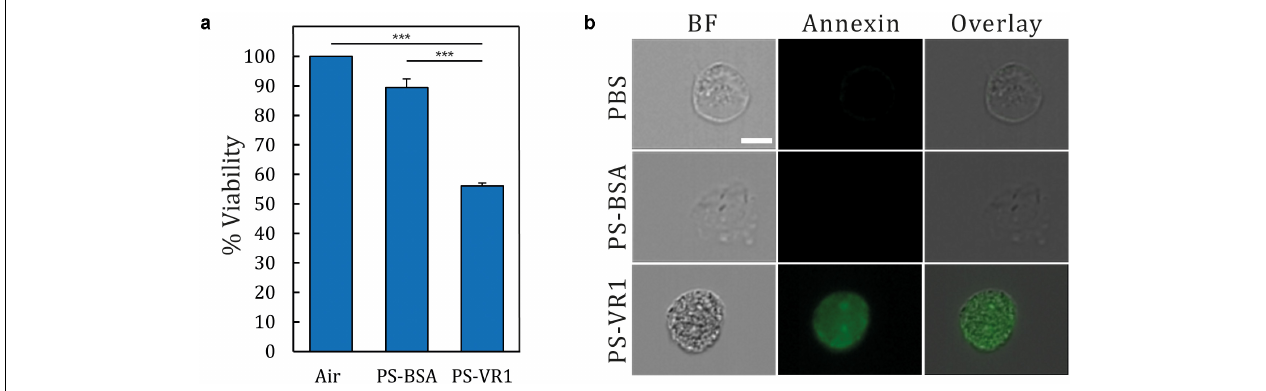
FIGURE 5 | Viability and apoptosis assay following NHBE cell exposure to PM-like particles. (a) Following inhalation exposure assays, airway-on-chip devices were returned to the incubator for 48 h prior to conducting a viability assay. The presented results are normalized to the air exposure, representing 100% viability ( n = 4 for each treatment). (b) Single cell imaging using Annexin V staining which stained apoptotic cells with green (BF corresponds to bright field). Error bar represent the standard error and asterisks indicate significance ( p < 0.001 shown as